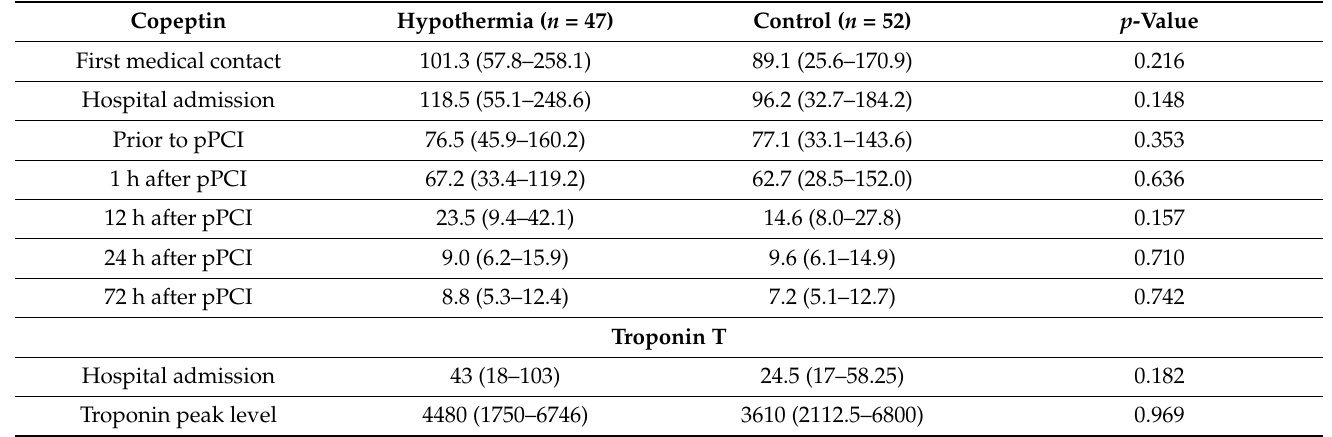
Table 2. Copeptin values as pmol/L [IQR] and Troponin T values as ng/L